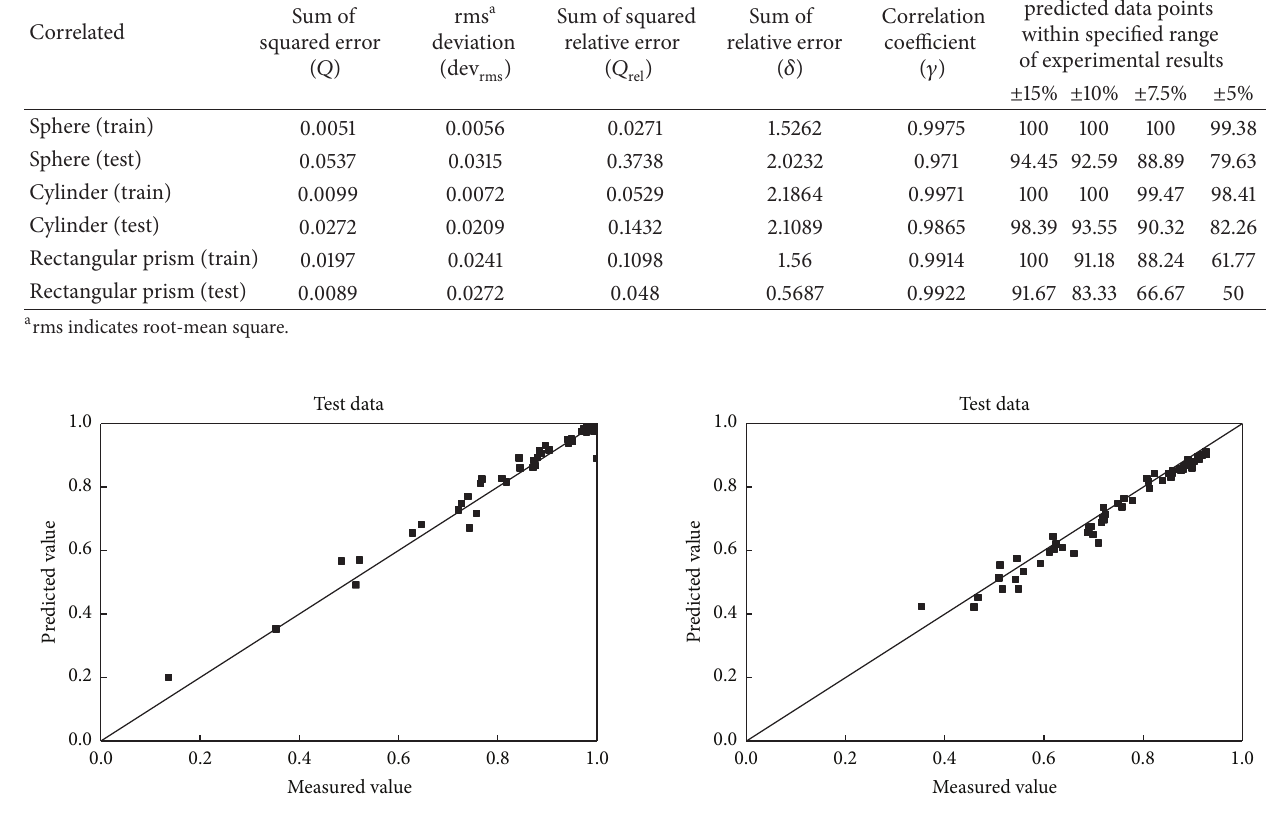
Figure 5: Comparison of the predicted and measured wall factors of cylinders for the test